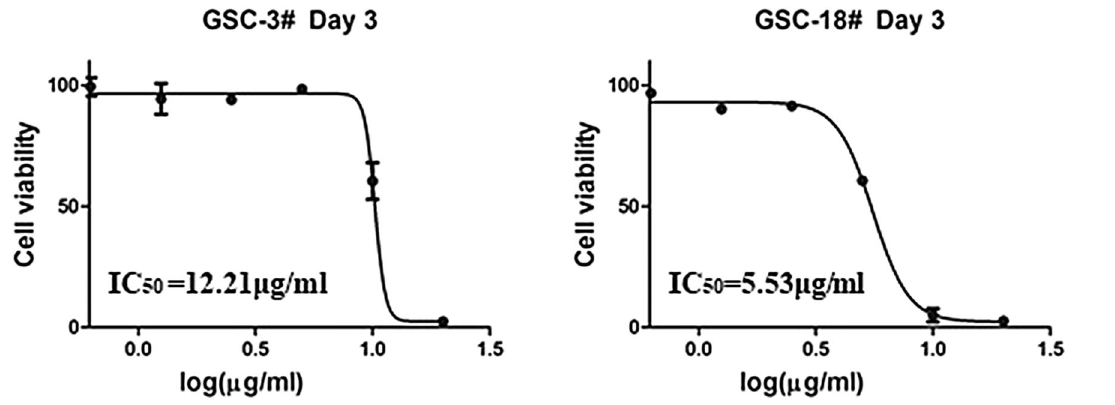
Fig. 5 The IC 50 value for compound 1 against human glioma stem cell lines Table 2 DPPH scavenging activity and yield of antioxidant constituents of the fruit of